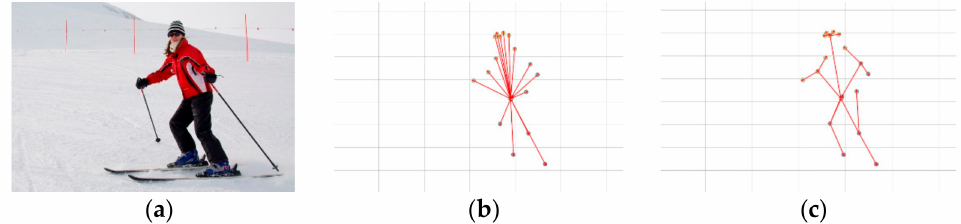
Figure 1. Different pose representations captured from image ( a ). ( b ) Traditional pose representation, in which each joint is represented by absolute coordinates. ( c ) Proposed partition pose